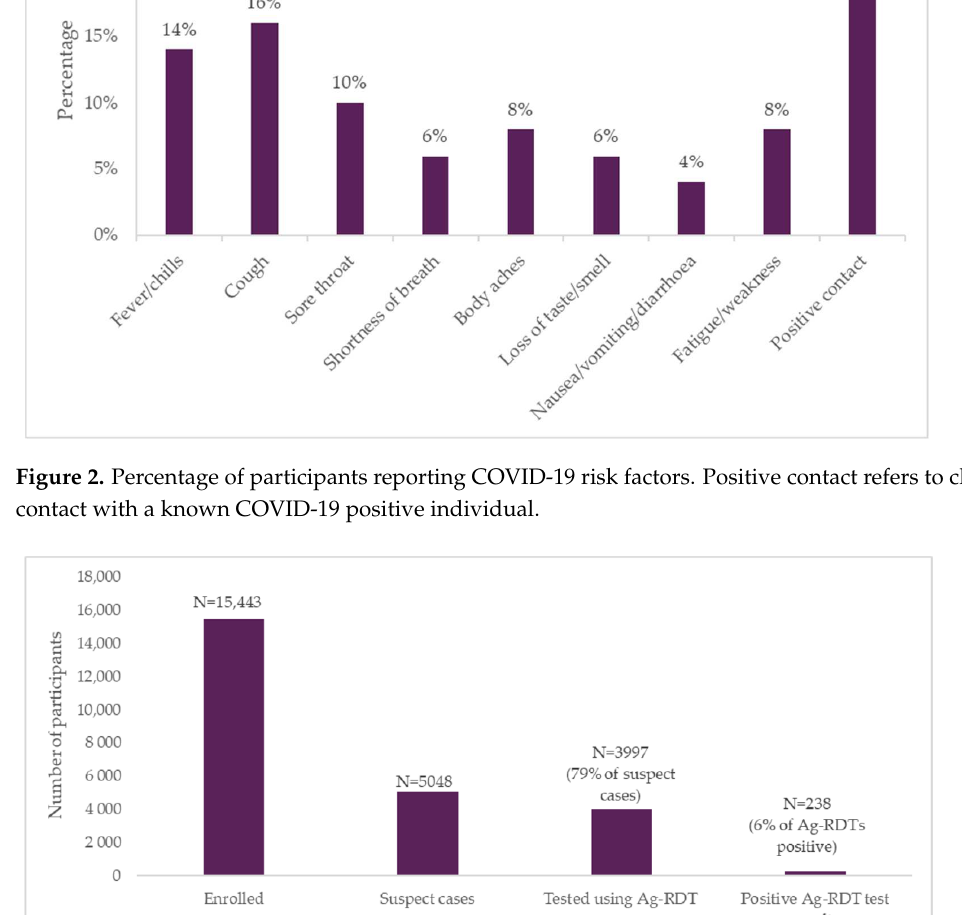
Figure 3. Suspect cases and SARS-CoV-2 testing at